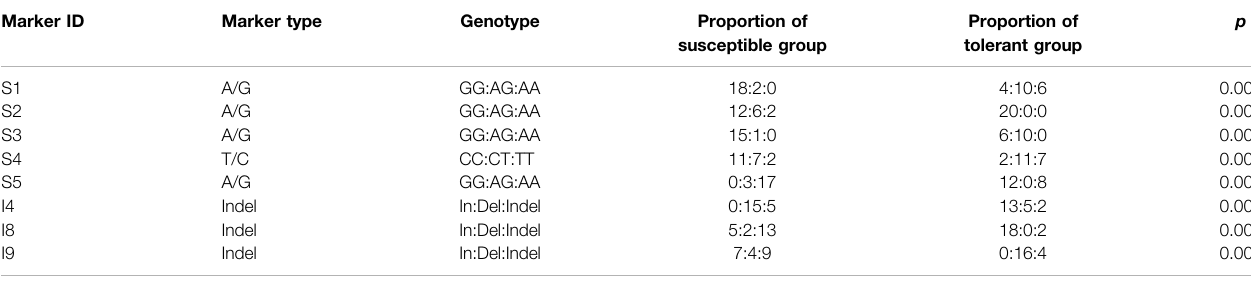
TABLE 4 | Genotyping information statistics.